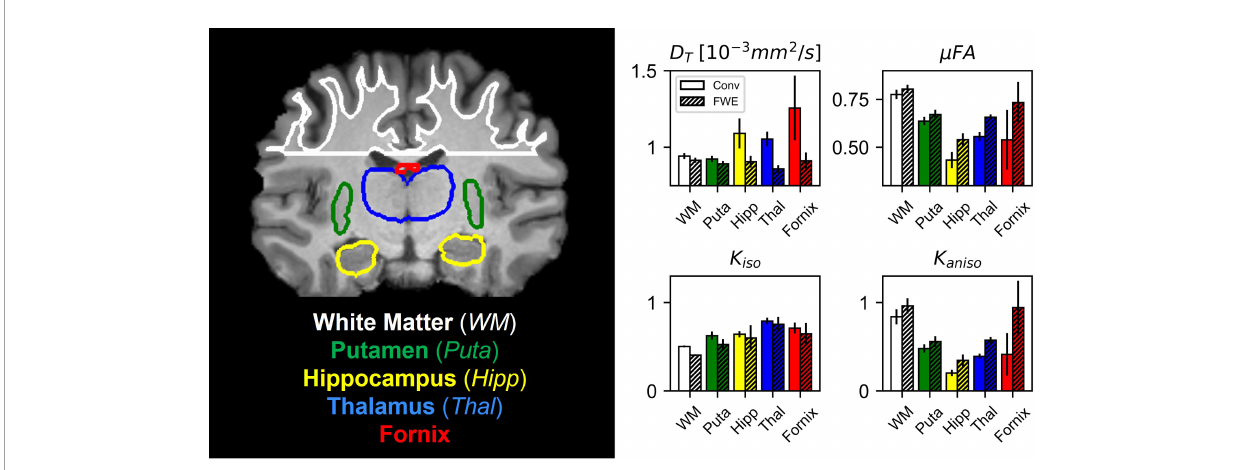
FIGURE7 Comparison between the conventional (Conv) and free water elimination (FWE) methods in four healthy volunteers. Depicted on the left is a coronal T1-weighted MPRAGE slice from one of the volunteers highlighting the five regions-of-interest (ROIs). Note that volumetric ROIs were used, despite the single slice depiction. On the right are plots comparing the mean diffusivity ( D T ), microscopic fractional anisotropy ( µ FA), isotropic kurtosis ( K iso ), and anisotropic kurtosis ( K aniso ) produced by the Conv and FWE methods. In all ROIs, D T and K iso were reduced when FWE was applied, while µ FA and K aniso were elevated, though the magnitude of this difference varied by region. Note that D T is used interchangeably with D for the conventional